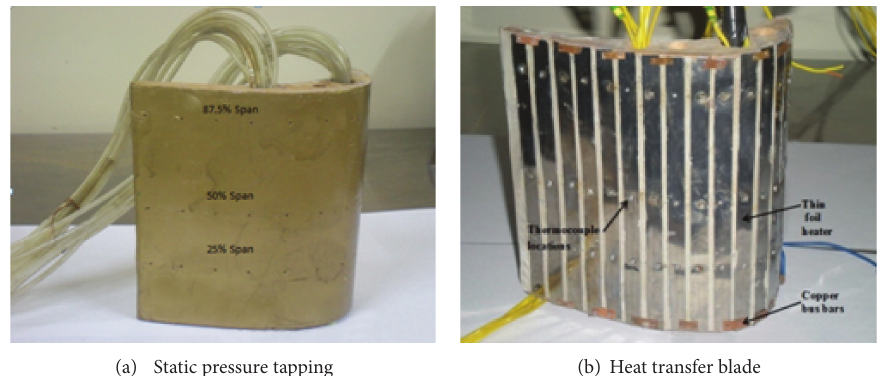
Figure 4: Instrumented